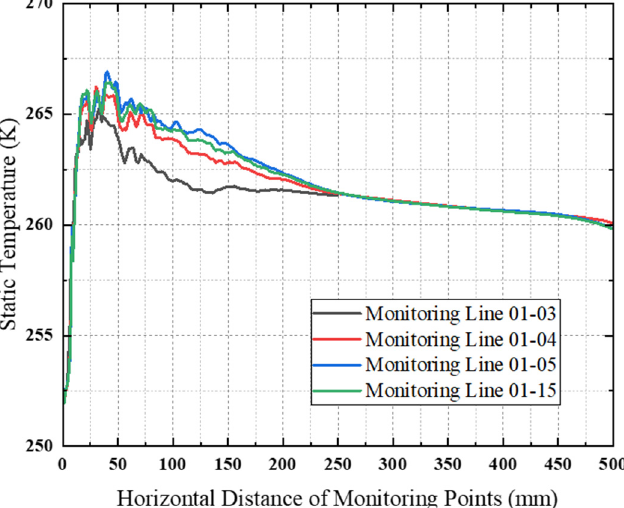
Figure 9. Line chart of the static temperature of the equal-diameter nozzle flow field. The compressed air pressure is 212,782 Pa. The temperature is 303 K.